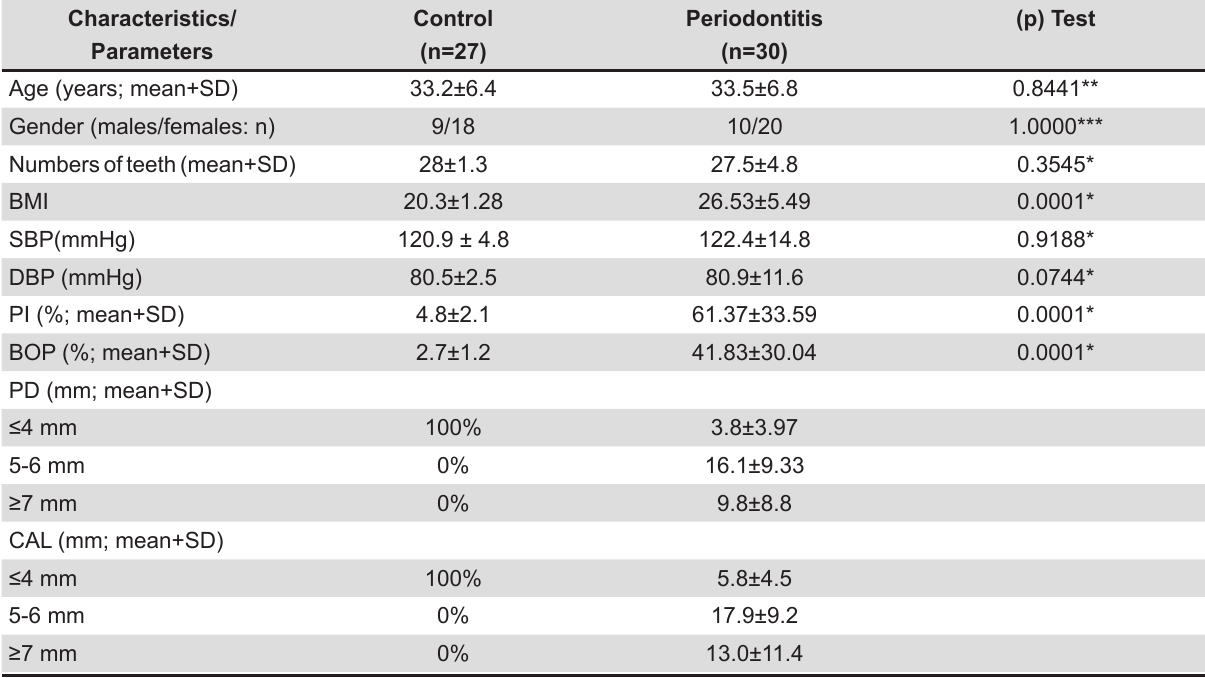
Table 1- Demographic characteristics and full-mouth clinical